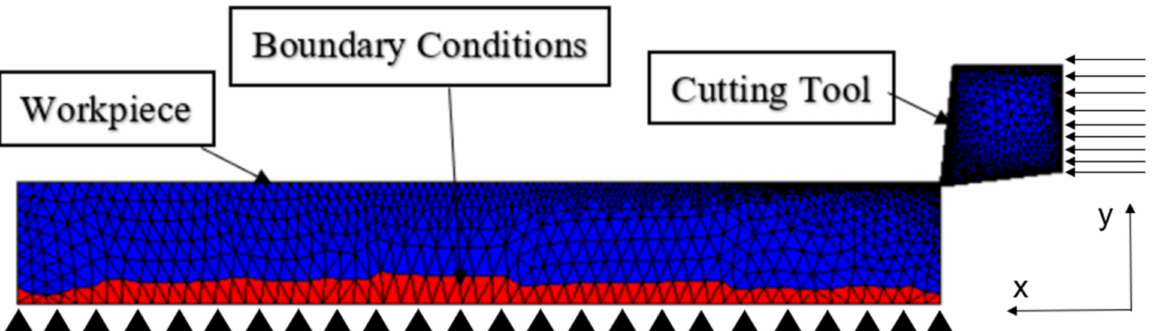
Figure 1. Boundary conditions for workpiece and cutting tool chosen for the FE model in AdvantEdge TM